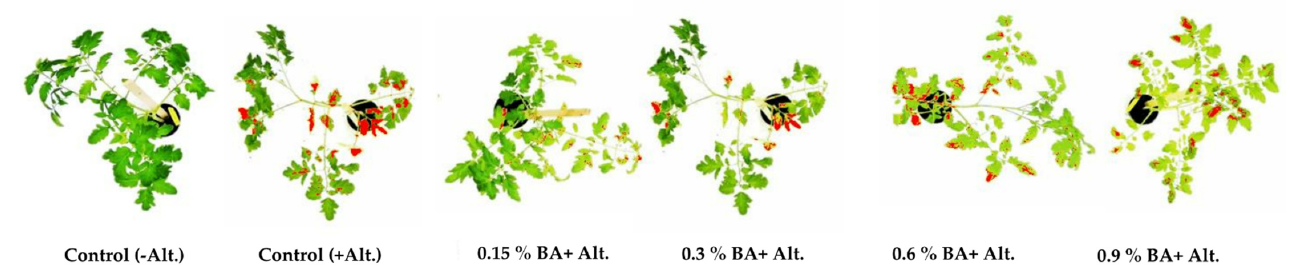
Figure 3. Early blight symptoms on tomato plants pretreated with BA, measured by software ImageJ 14 days after inoculation with Alternaria alternata .